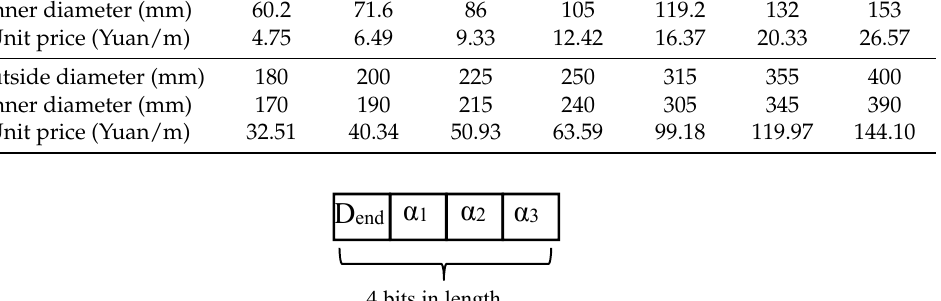
Figure 6. Code string for the optimization of the BLPN subsystem. Figure 5. Sketch of a branch pipe.